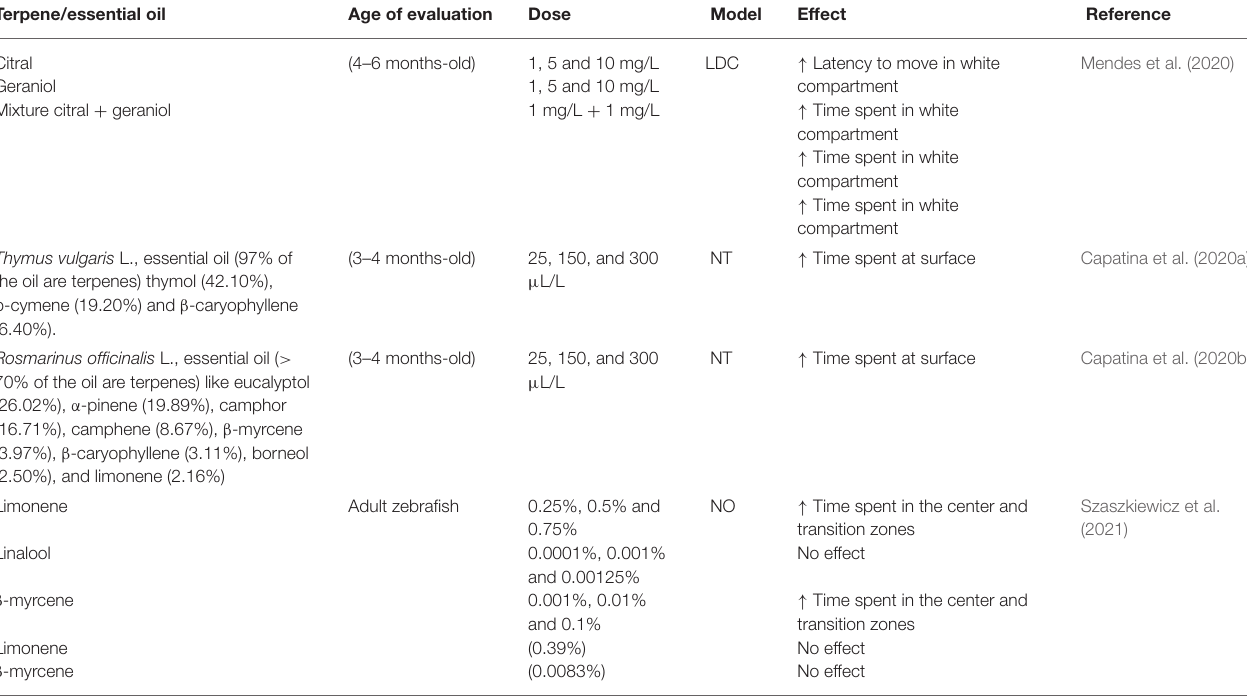
TABLE 4 | Behavioral effects of terpenes and essential oils in adult zebrafish. Terpene/essential